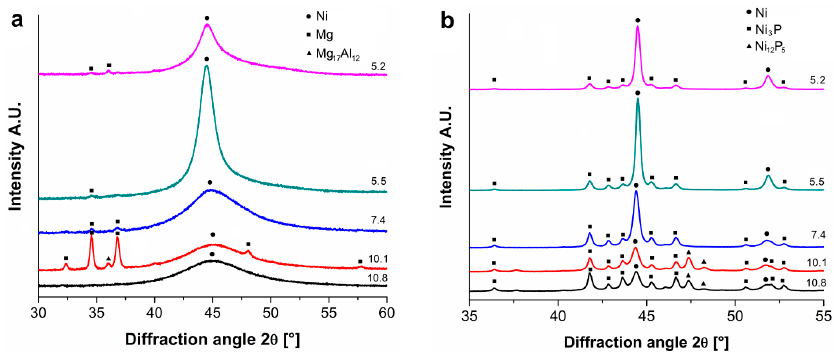
Figure 4. XRD patterns of ( a ) as-deposited and ( b ) heat-treated Ni–P coatings with different phosphorus content.